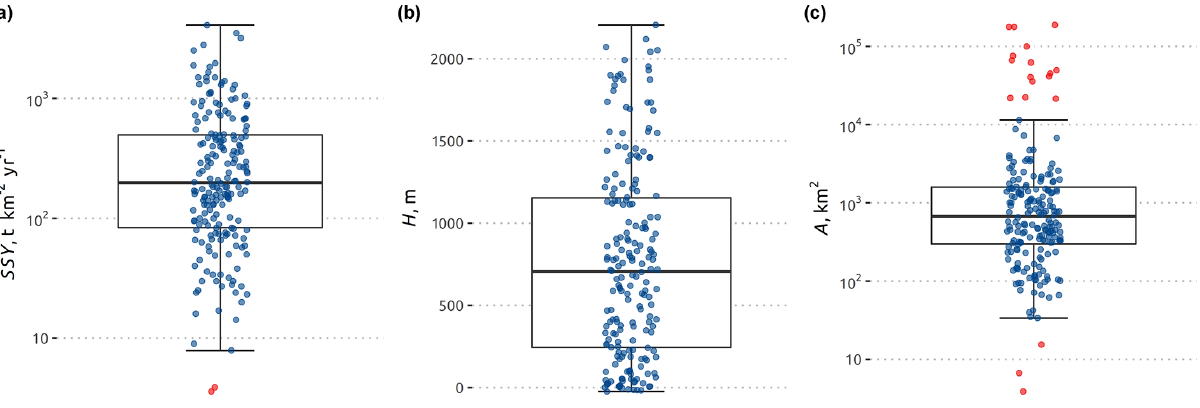
Figure 2. Distribution of SSY observations in our database (a) and boxplots of elevations of the gauging stations (b) and their catchment areas (c)